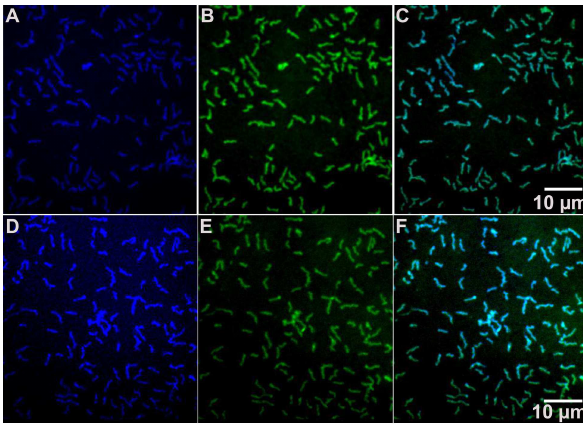
Figure 7. Localization of Mp AFP by immunofluorescence. Immobilized M. primoryensis cells were fixed in 1% paraformaldehyde before being incubated with anti-RII (A, B and C) or anti-RIV (D, E and F) polyclonal antibodies, followed by Alexa Fluor 350 - conjugated goat anti-rabbit secondary antibody (blue in A and D) and SYTO 9 (green in B and E). Images (C) and (F) are composite images of (A) and (B), and (D) and (E), respectively. A 10-micron scale marker is shown by the white horizontal line in panels C and